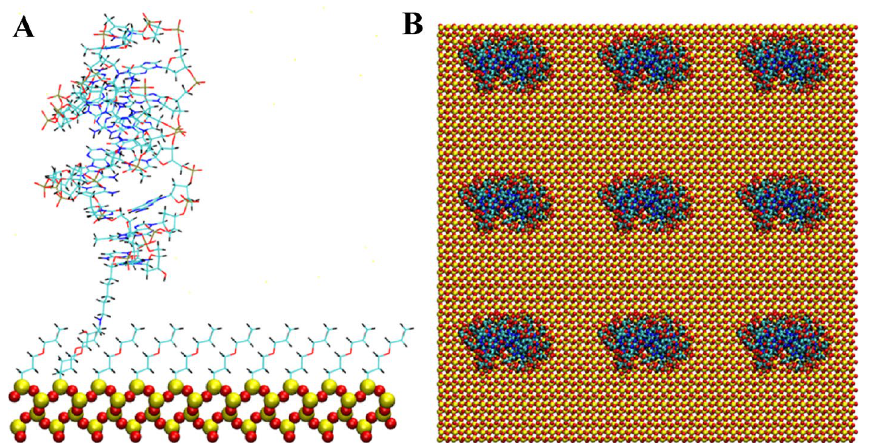
Figure 3. Anti MUC1 aptamer tethered to SiO 2 biosensor substrate in configuration 2 (5 ′ end attachment, perpendicular to surface, low density). ( A ) Side view of simulation cell ( B ) Top view with periodic display. Water and ion molecules are not